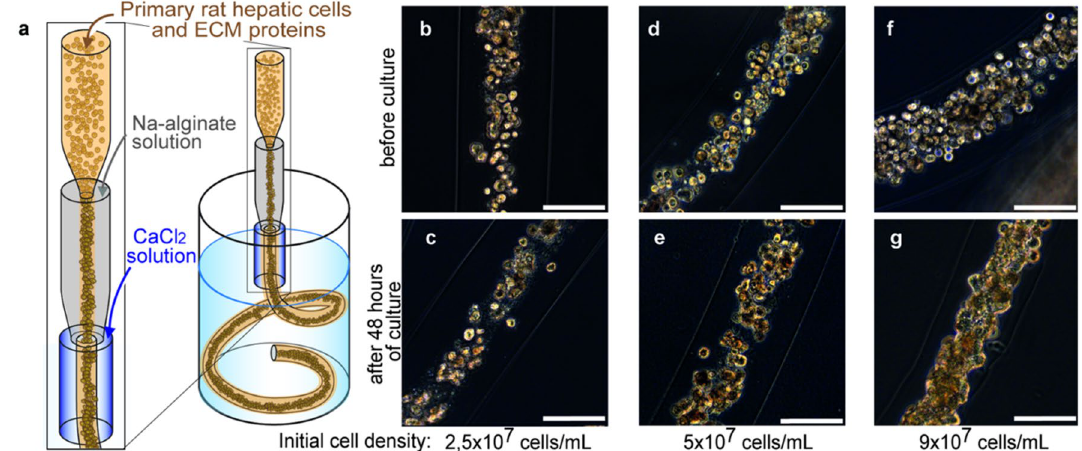
Figure 1. Encapsulating primary rat hepatocytes within core–shell hydrogel microfibers by applying cell fiber technology. ( a ) Schematic drawing of the fabrication of core–shell hydrogel microfibers encapsulating freshly isolated rat hepatocytes through a double co-axial microfluidic device. ( b–g ) Representative dark-field images (n = 12 cell fibers for each group) of primary rat hepatocytes encapsulated in cell fibers before culture and after 48 h of culture in three experimental groups possessing different initial cell seeding densities: 2.5 × 10 7 cells mL −1 , 5 × 10 7 cells mL −1 , and 9 × 10 7 cells mL −1 . Scale bars; 100